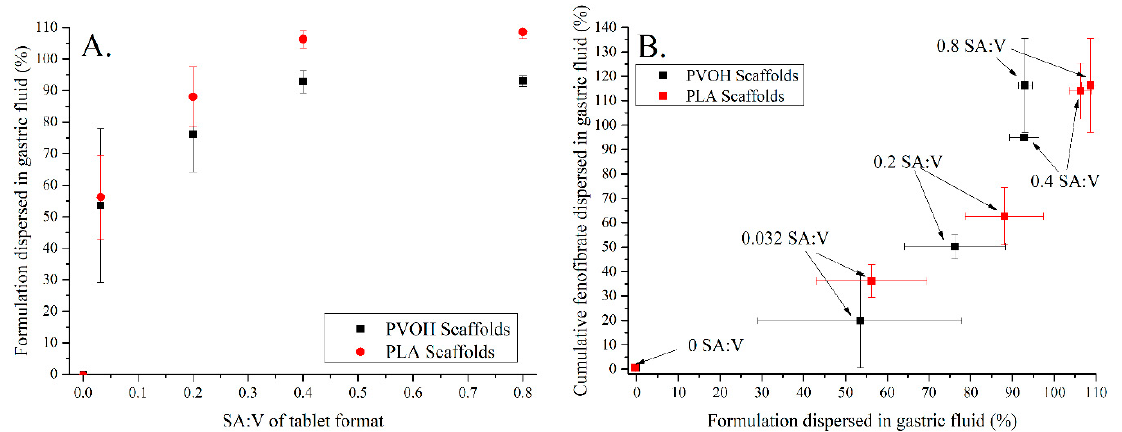
Figure 12. (A) Relationship between dispersion of the formulation and surface area-to-volume ratio (SA:V) and (B) the dependence of drug release on dispersion of the formulation across the range of SA:V studied. Black symbols indicate PVOH-based scaffolds; red symbols indicate PLA-based tablets after 20 min of dissolution time in simulated gastric media.